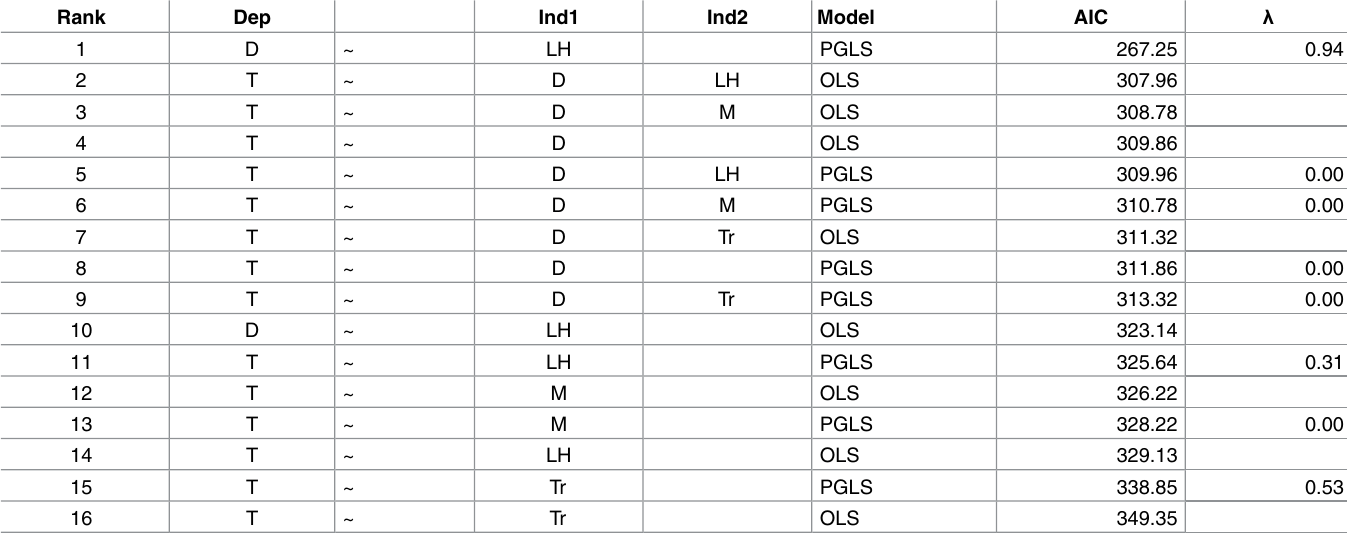
The PGLS analysis showed that the best performing model describedthe relationship between distribution and life history with phylogeny taken into account (PGLS; Table 2). This model had a very strong phylogenetic signal, showing that more closely related species had a Table 2. Rankedresultsof phylogeneticleastsquaresanalysispredictive